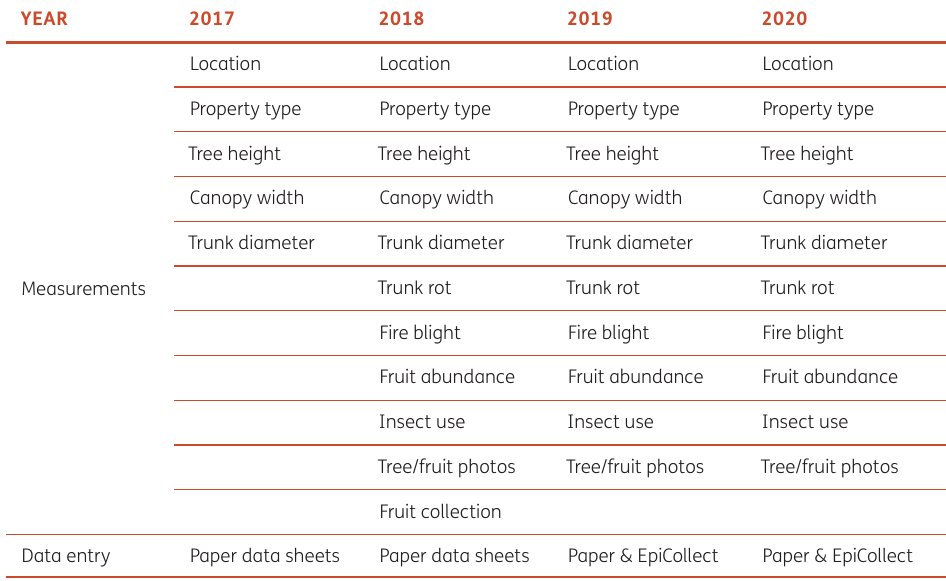
Table 2 Summary of measurements by year and data entry